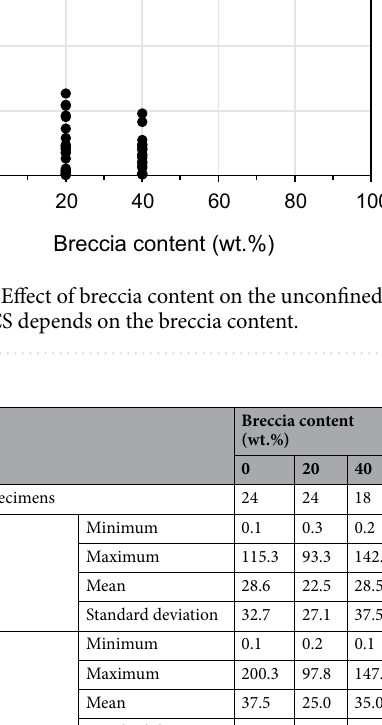
Table 7. Elastic modulus (E s50 and E t50 ) of artificial fault core for breccia contents of 0, 20, and 40 wt.%.